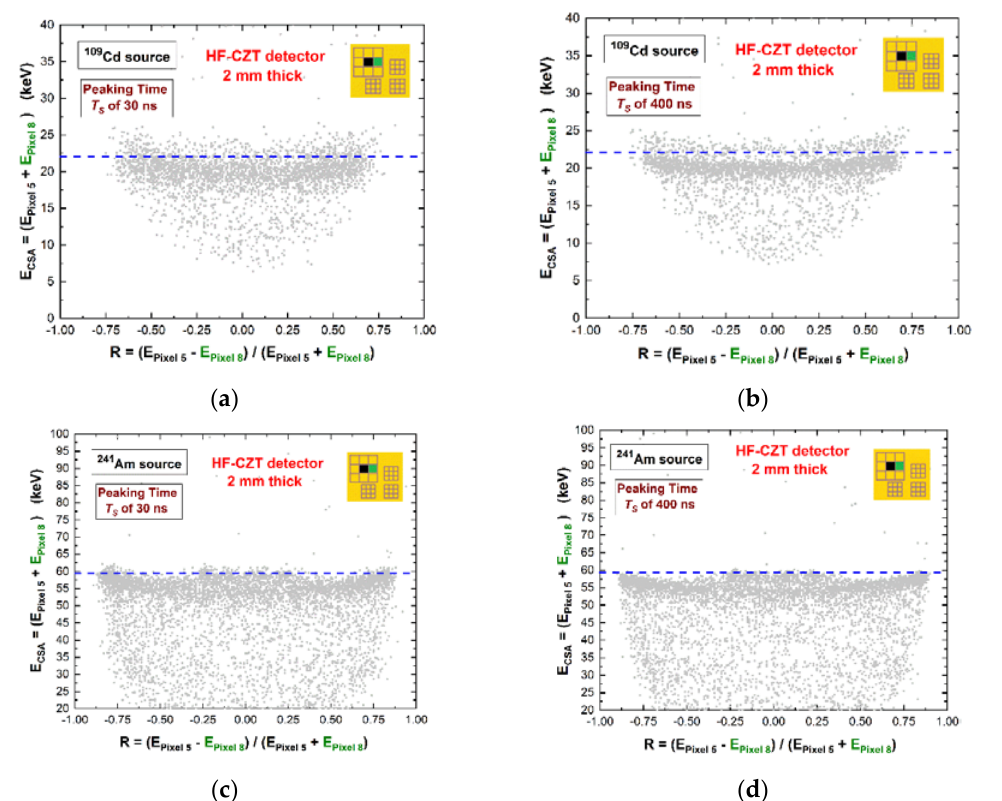
Figure 10. Two-dimensional (2D) scatter plot of the summed energy of the coincidence events (multiplicity m = 2) between pixel no. 5 and pixel no. 8 after, the charge sharing addition (CSA), versus the sharing ratio R . ( a , c ) Ballistic deficit pulse processing; ( b , d ) energy resolution pulse processing. The blue dashed lines represent the true energy.